Question: Express in one sentence what the figure is showing.
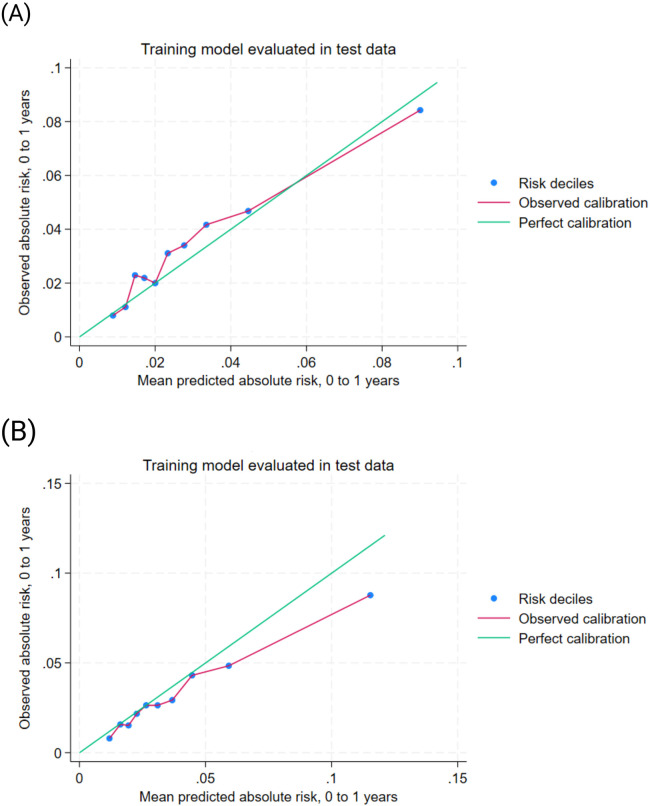
Answer: Calibration plots for the best predictive models of 0–1 year TLR risk. (A) Calibration plot for Cox regression with backward elimination; (B) Calibration plot for Cox-LASSO. Created in BioRender. El-Faramawi, M. (2026) https://BioRender.com/grcva42 .